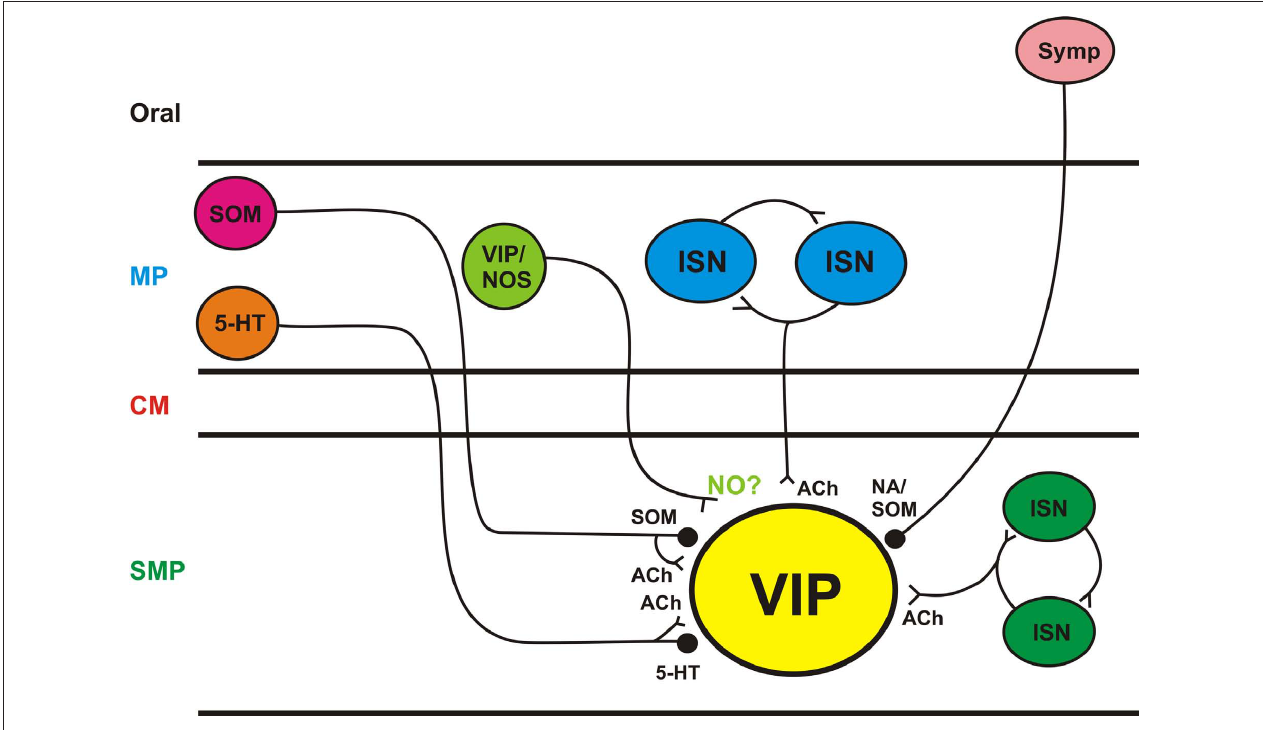
non-noradrenergic IPSPs and myenteric neurons immunoreactive for VIP/ nNOS are the probably source of endogenous NO released by electrical stimuli. SMP submucosal plexus, CM circular muscle, MP myenteric plexus, ACh acetylcholine, < denotes an excitatory synapse, denotes an inhibitory